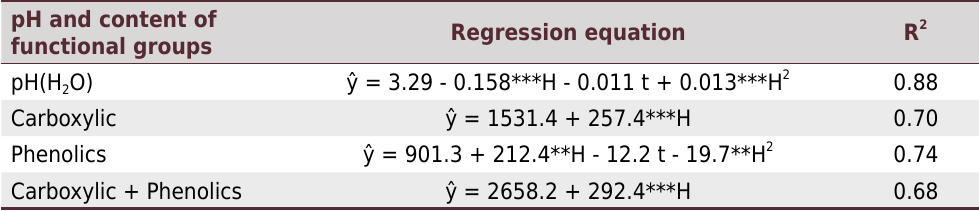
Table 3. Regression equations adjusted to pH in water and functional groups contents according to the concentration of HNO 3 (H) and reaction time (t) expressed in